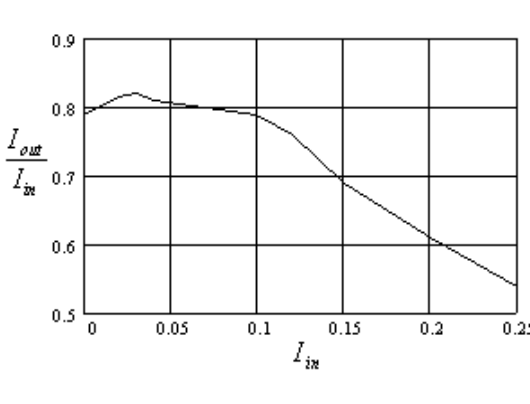
FIG. 5. Transmission versus input current A